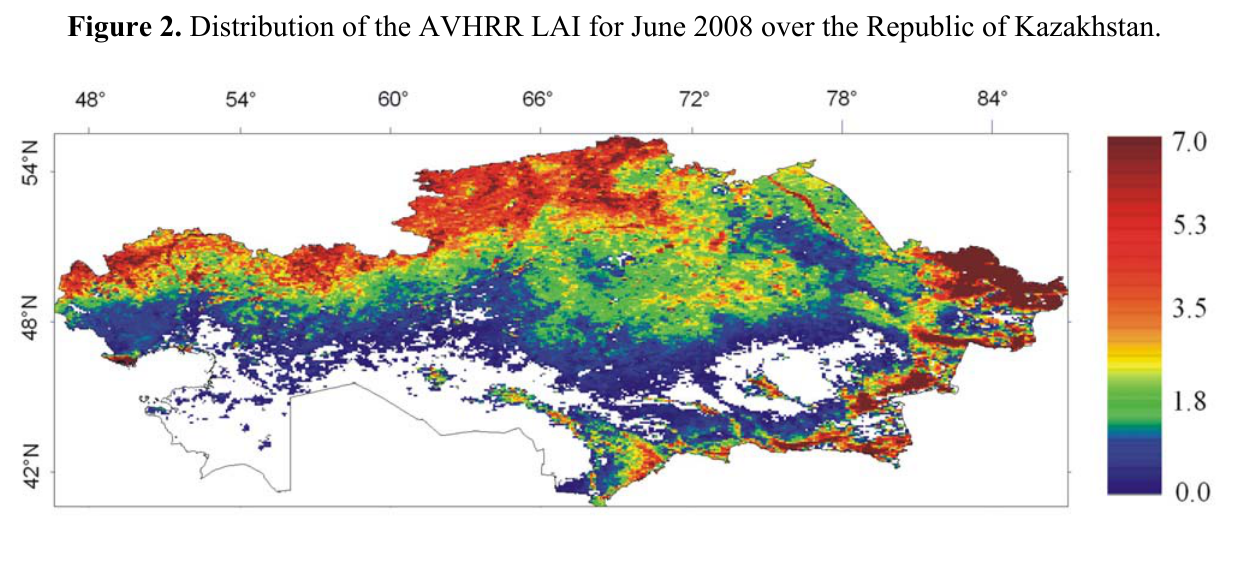
Figure 3. Monthly courses of the area-averaged LAI derived from the national-wide AVHRR LAI data set for the period